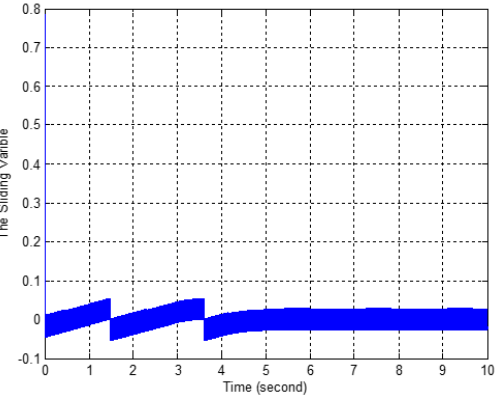
Fig. 9. The control action u vs. time of the